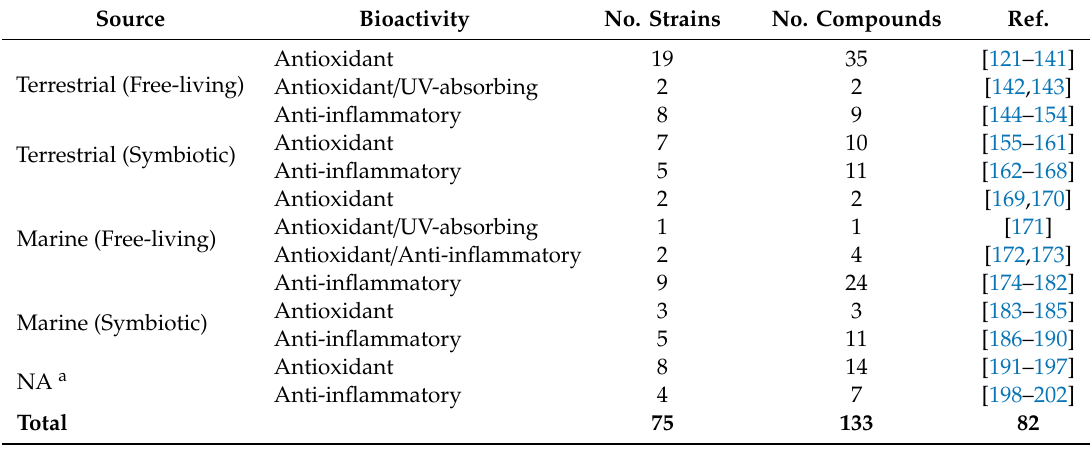
Table 3. Numberof Streptomyces